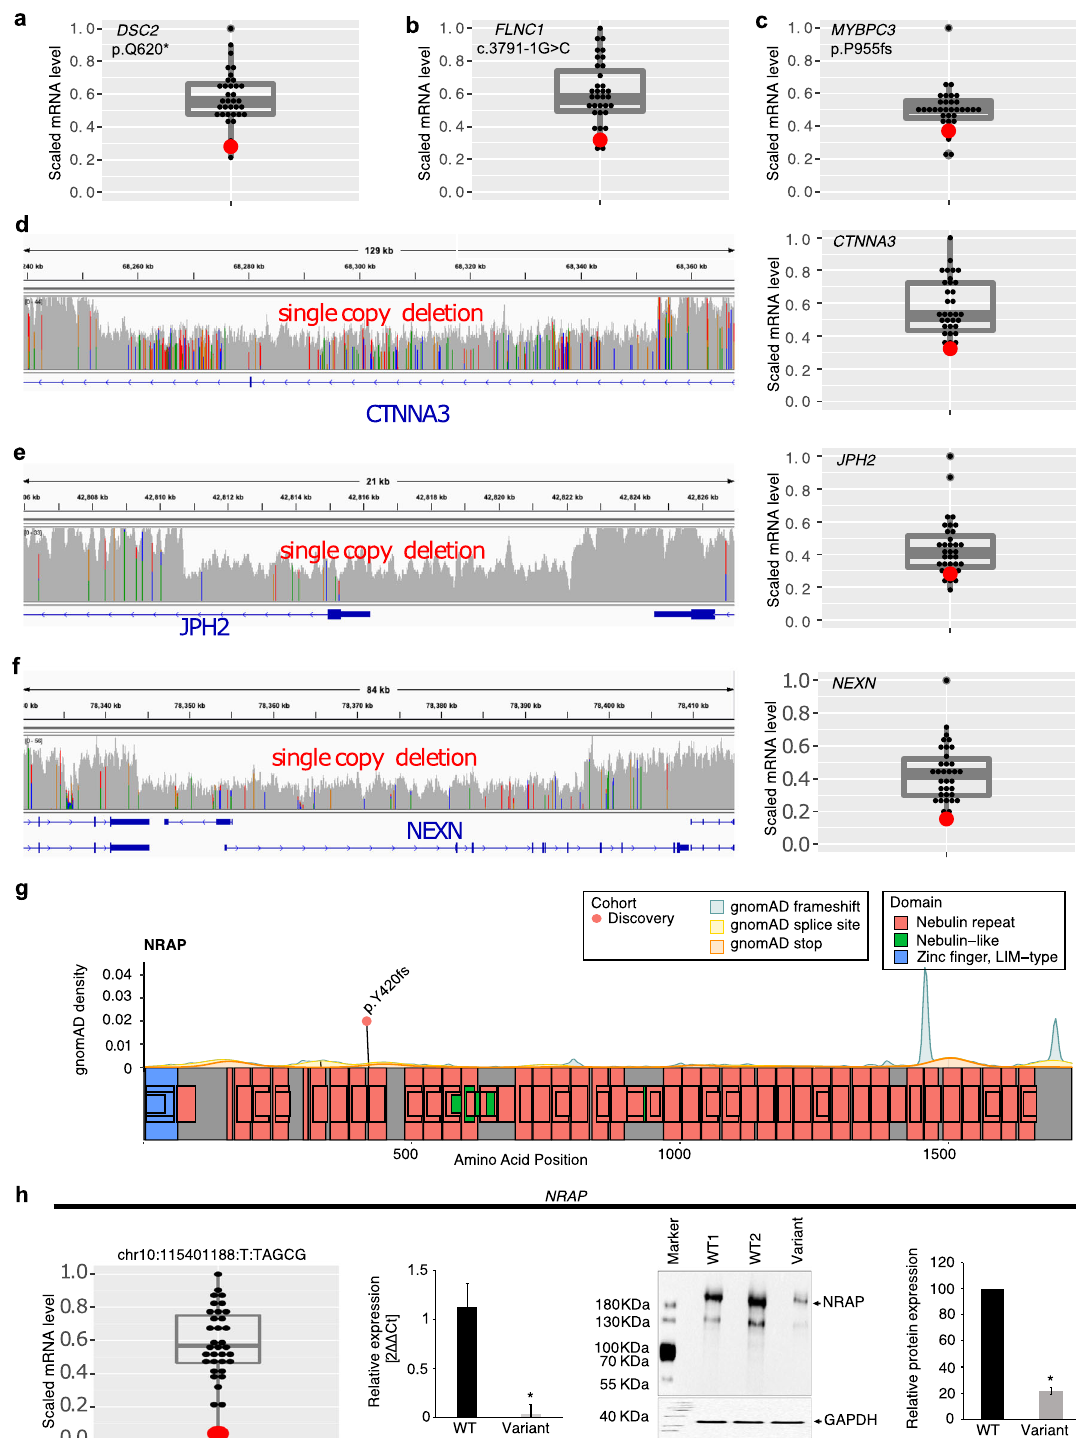
Table 2). The majority of genes (12 of 16) enriched for high-risk regulatory variants were primary CMP genes. Case – control burden analysis using the ICGC control cohort con fi rmed an enrichment of regulatory variants in cases compared to controls (OR = 2.25,